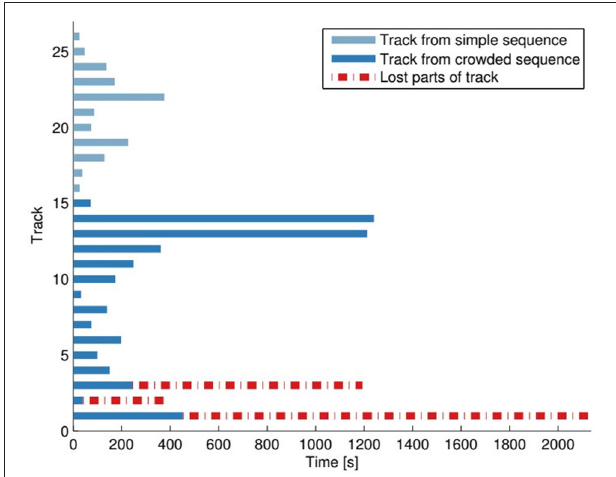
FIGURE 6 | Here all 26 tracks in the dataset are shown in the y -axis and how long the tracker was able to follow each of them in the simple/crowded